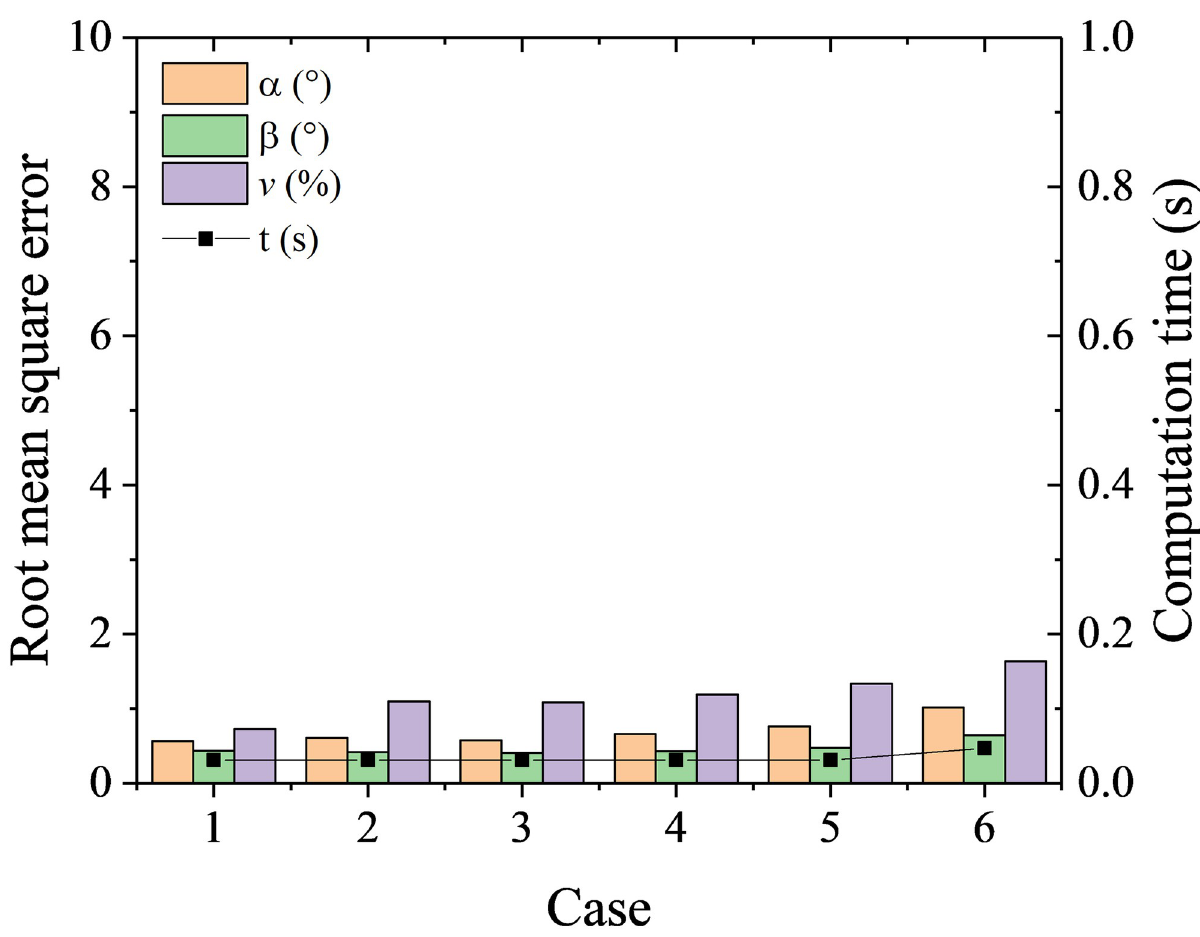
Fig 6. RMSEs and computation time at different cases with K-nearest